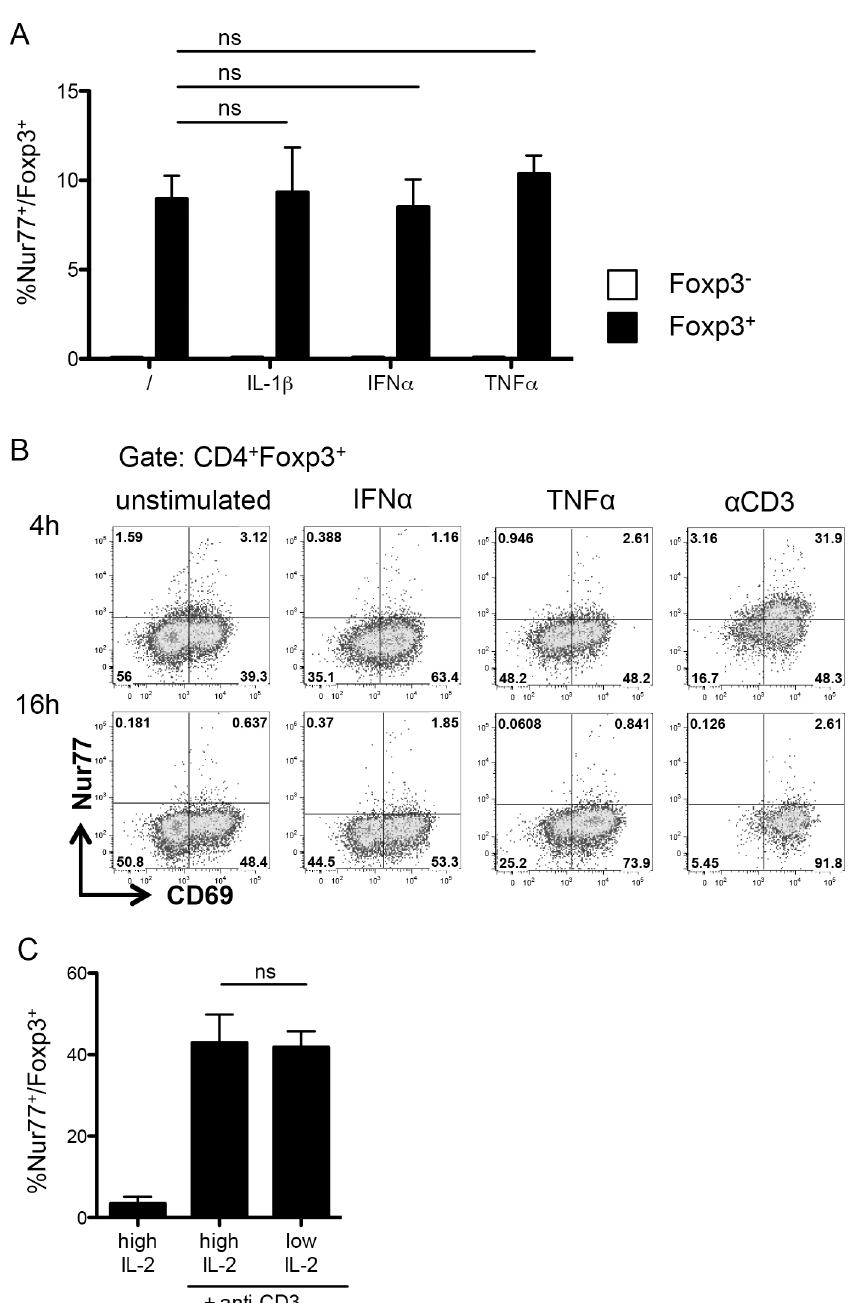
Fig 4. Nur77 intensity is not modulated by cytokines. (A) Nur77 expression on Foxp3 - (white bars) and Foxp3 + (black bars) CD4 + T cells from the culture in Fig 2B. Data are representative of at least two independent experiments. (B) Representative plots of Nur77 versus CD69 expression on Foxp3 + among enriched CD4 + T cells, stimulated for 4 hours (top row) or 16 hours (bottom row) without additional cytokines (/), with IFN- α , TNF- α , or plate-bound α CD3. Data are representative of two independent experiments. (C) Nur77 expression on Foxp3 + cells among sorted CD25 + CD4 + splenocytes stimulated with plate-bound α CD3 with low (1U/ml) or high (1000U/ml) IL-2 for 6 hours. Data are representative of four independent experiments. Data show mean + SD, ns, non